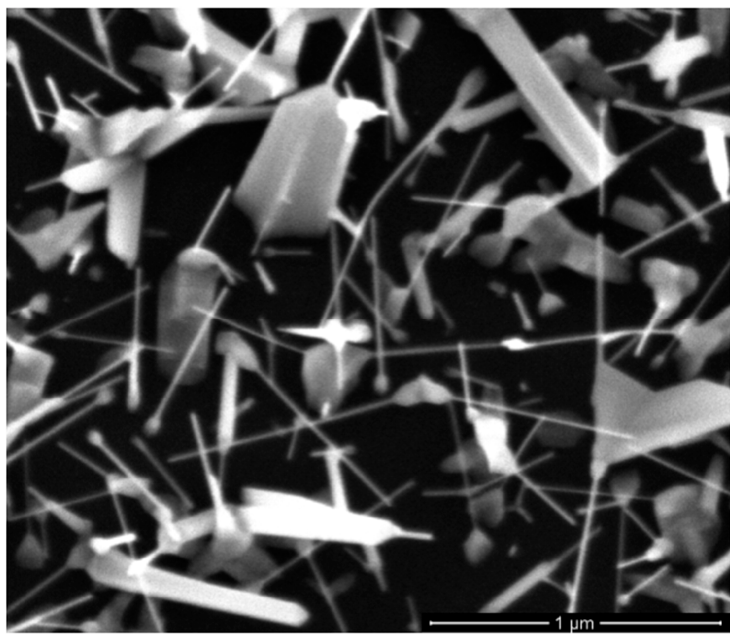
Figure 3. SEM image top view of ZnO nanowires (NWs) grown at 5 Torr in argon environment, T = 380 °C on silicon substrate . T = 380 ◦ C on silicon